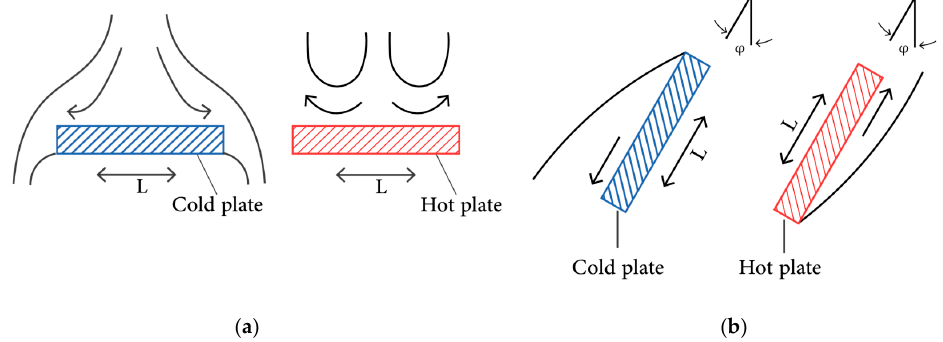
Figure 7. The external natural convection process for ( a ) upper horizontal plate and ( b ) inclined plate.